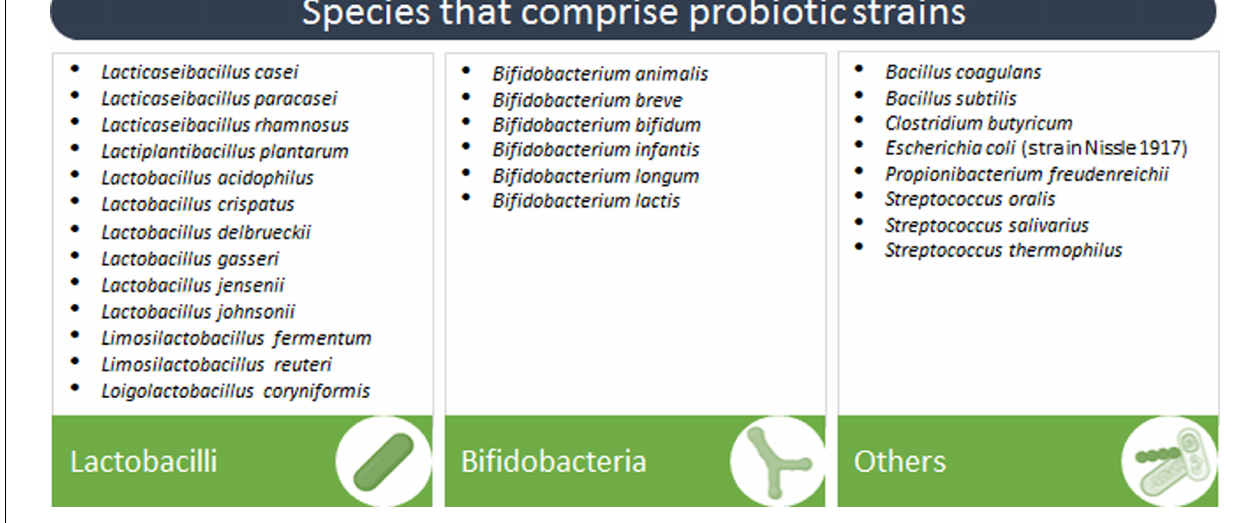
FIGURE 1 | Species that comprise probiotic strains assessed for the prevention or treatment of infectious diseases in clinical